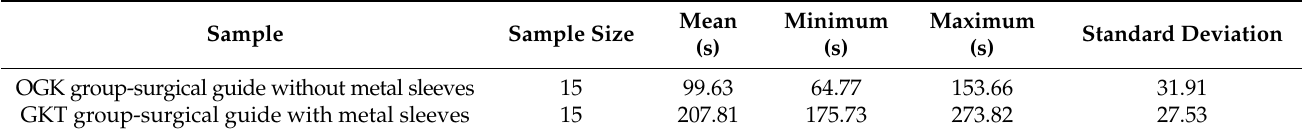
Table 1. Results of basic statistical analysis.